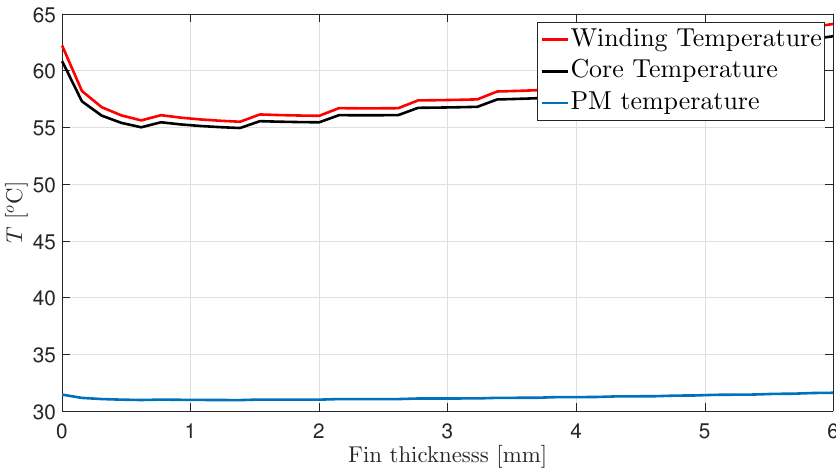
Figure 19. The winding, the core and the PM temperature variation with the fins thickness.